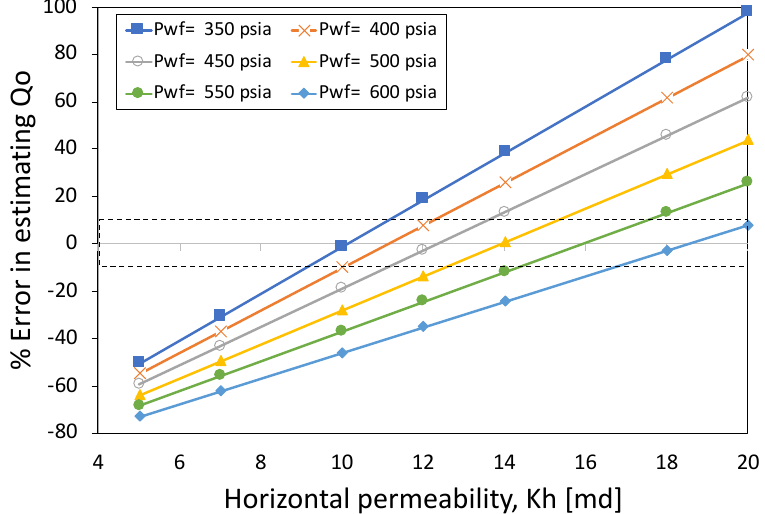
Figure 7. Errors in estimated well production rate; the coupled effect of uncertainties in bottom-hole pressure and horizontal permeability (Well #1).